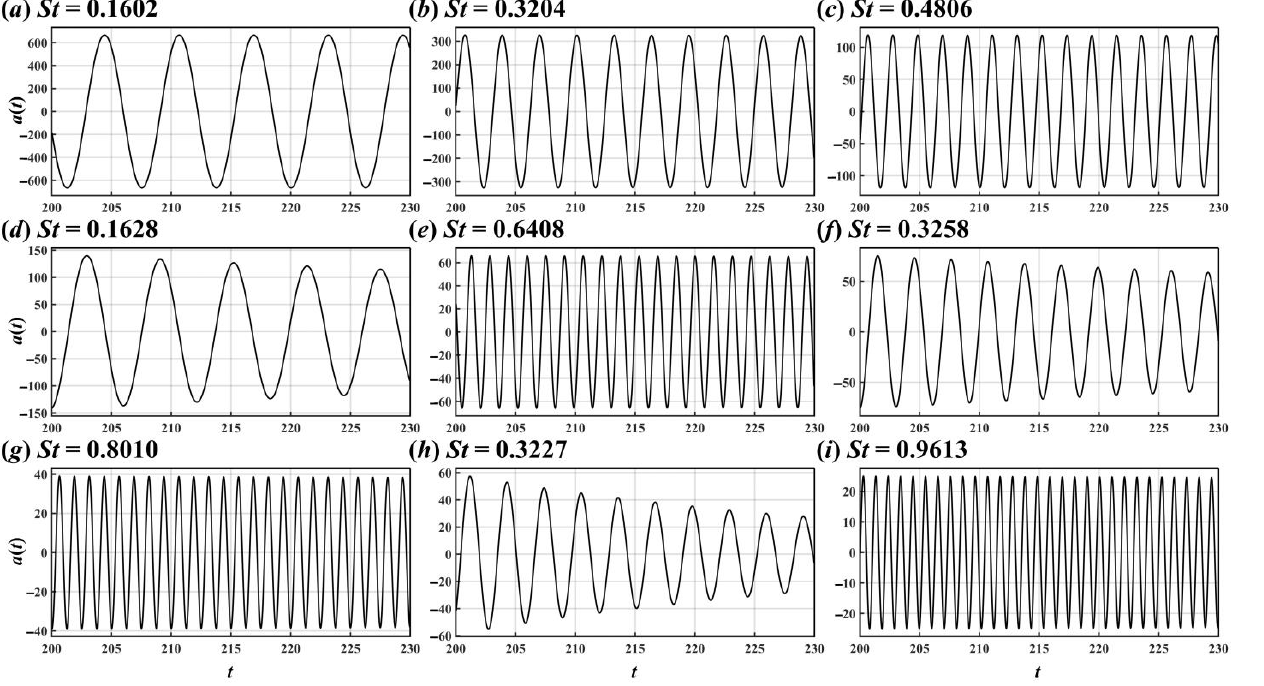
Figure 26. Time coefficients of the St = 0.1602 ( a ), 0.3204 ( b ), 0.4806 ( c ), 0.1628 ( d ), 0.6408 ( e ), 0.3258 ( f ), 0.8010 ( g ), 0.3227 ( h ), and 0.9613 ( i ) DMD modes for the flow around the two crossing cylinders in 60° arrangement.